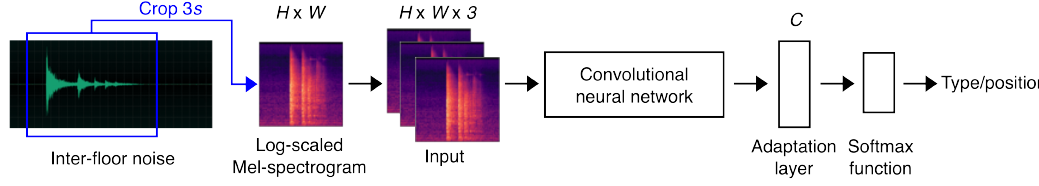
Figure 4. Architecture of the inter-floor noise type/position